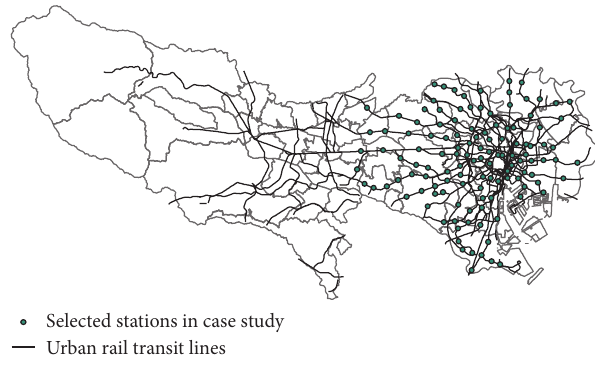
Figure 1: URT in Tokyo metropolitan